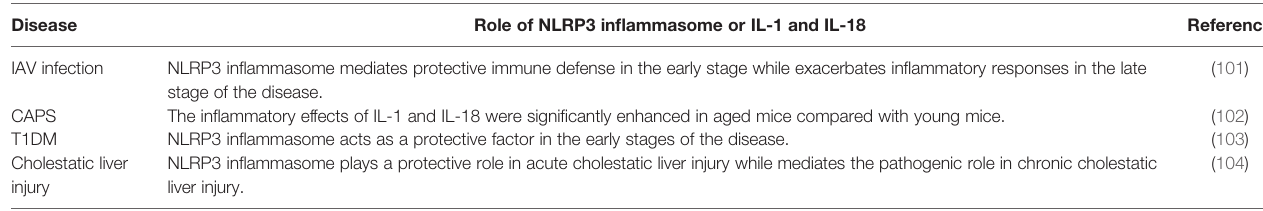
TABLE 1 | Role of NLRP3 in fl ammasome in different stages of different diseases. Disease Role of NLRP3 in fl ammasome or IL-1 and